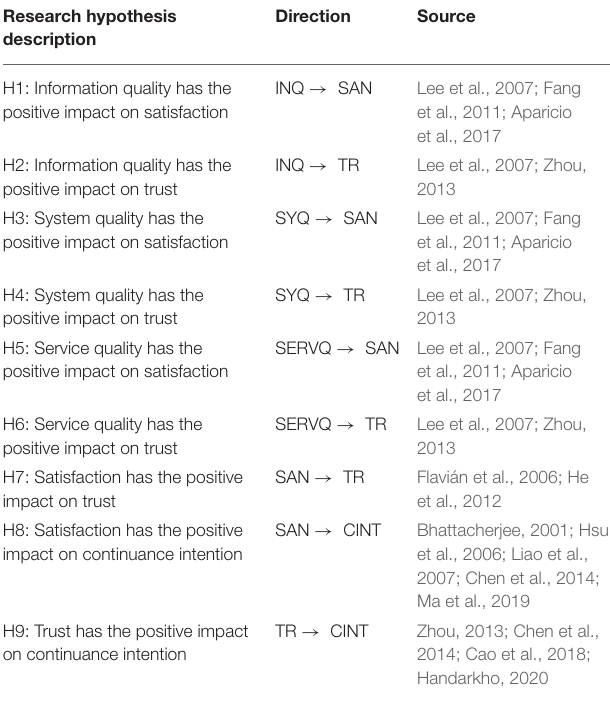
TABLE 1 | Research